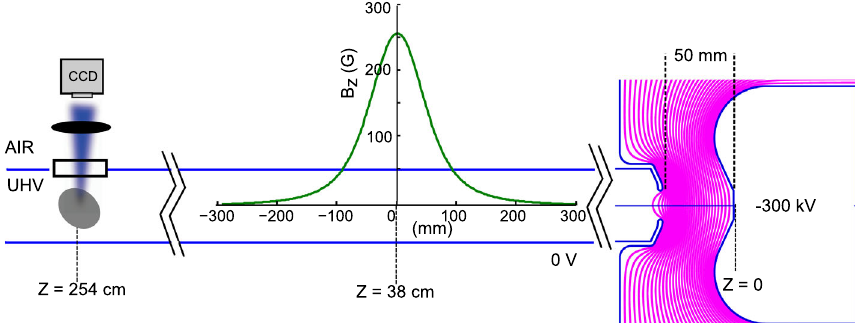
FIG. 4. Layout of the electron beam line, including the photogun (purple equipotential lines), imaging solenoid, and BeO fluorescent viewscreen and fluorescence profiling camera.